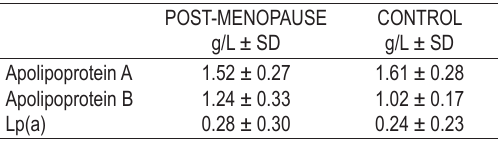
TABLE 2. Total values of apolipoprotein A, apolipoprotein B and Lp(a) levels in blood of post-menopausal and control group of pre-menopausal